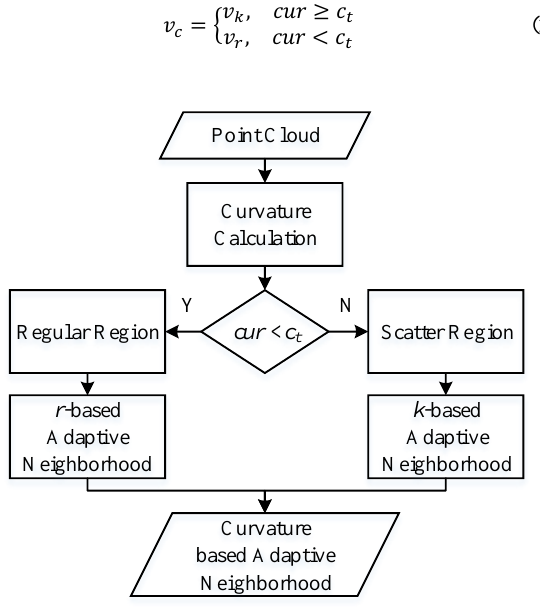
Figure 3. Sketch map of point cloud curvature based adaptive